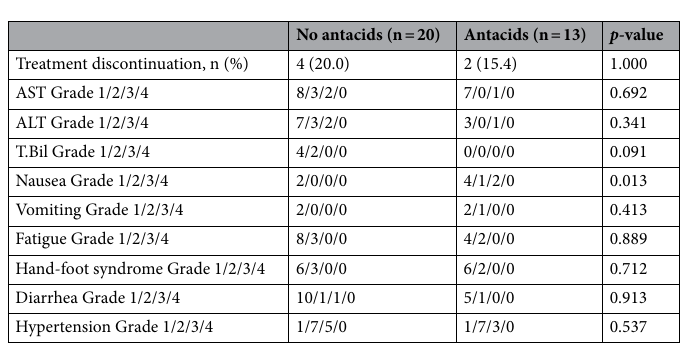
Table 3. The relationship between antacids and adverse events, treatment discontinuation. Two-tailed Fisher’s exact test. AST, Aspartate aminotransferase; ALT, Alanine aminotransferase; T.Bil, Total